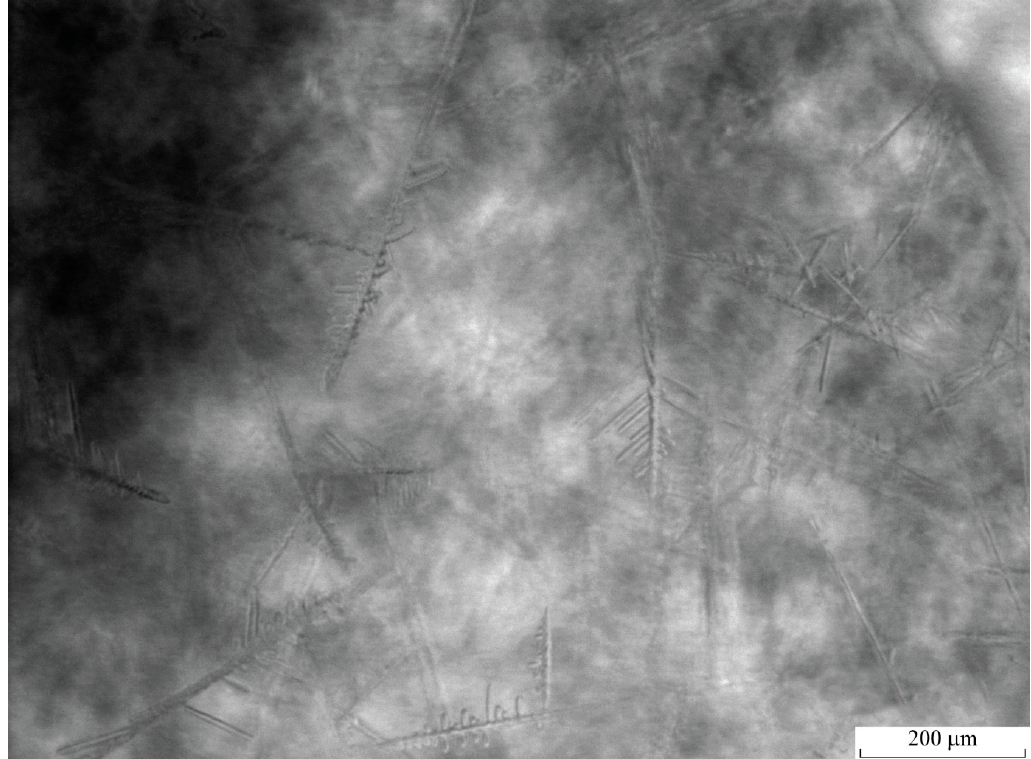
Figure 8. The acicular form of xenon hydrate; observed at +9 °C, 8 atm.